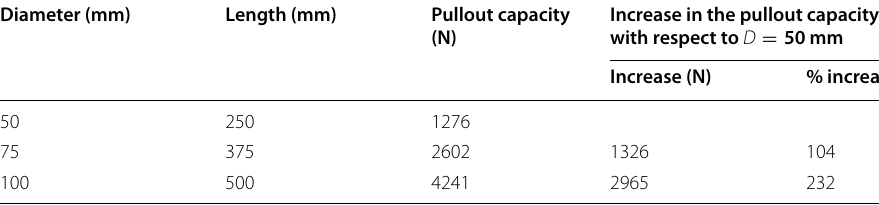
Table 7 Effect of the diameter on the pullout capacity for a single GPA with L / D Diameter (mm) Length (mm) Pullout capacity